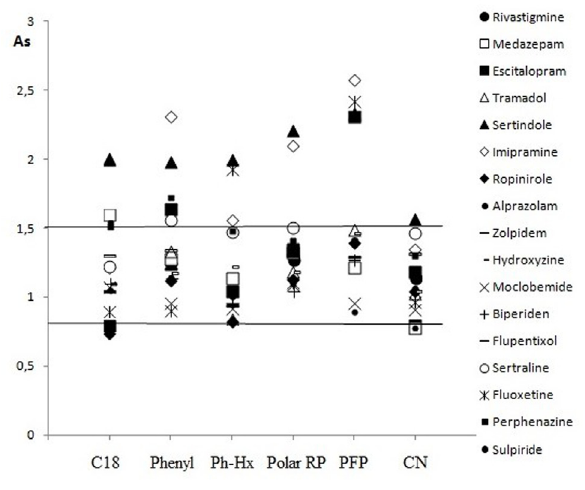
Figure 3: Graphical comparison of As values obtained on different columns with mobile phases containing as eluent 55% methanol, 20% acetate buffer at pH 3.5 and 0.025 ML -1 DEA.